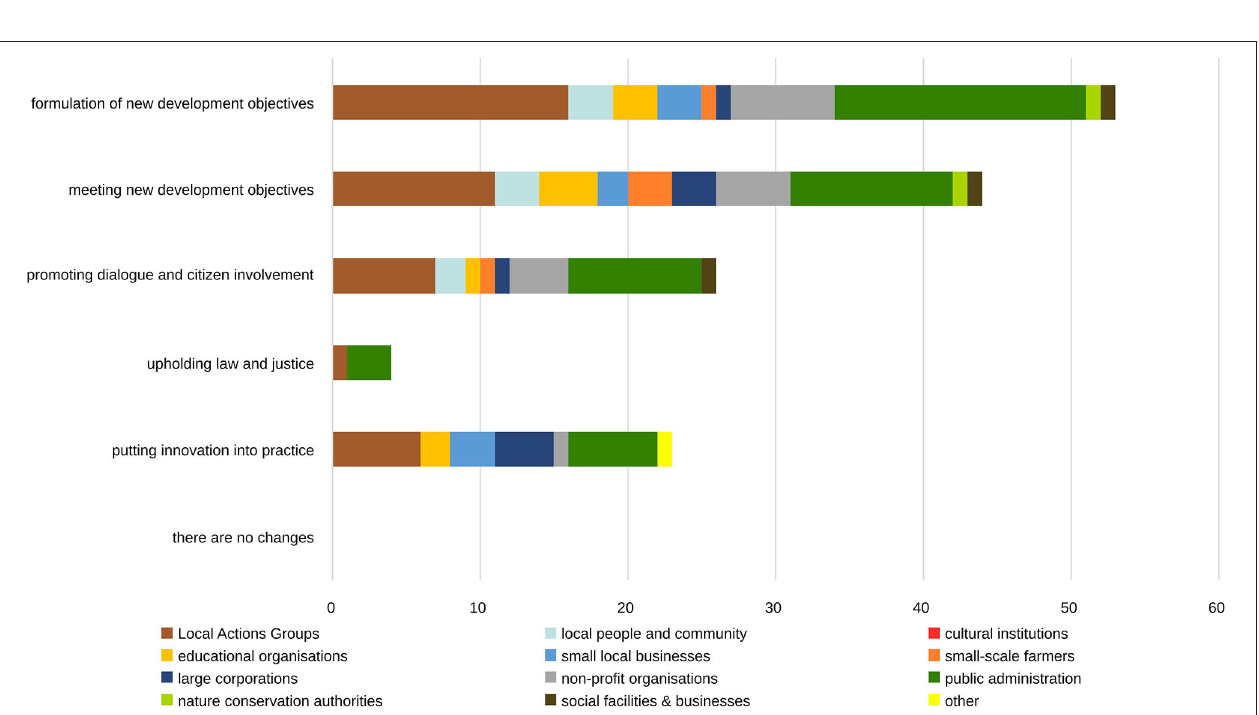
FIGURE 3 | Extent of the LAGs’ cooperation with other actors, n = 41. Answers to the multiple-choice question “How do you evaluate cooperation of your LAG with various actors of public administration and external institutions?” .